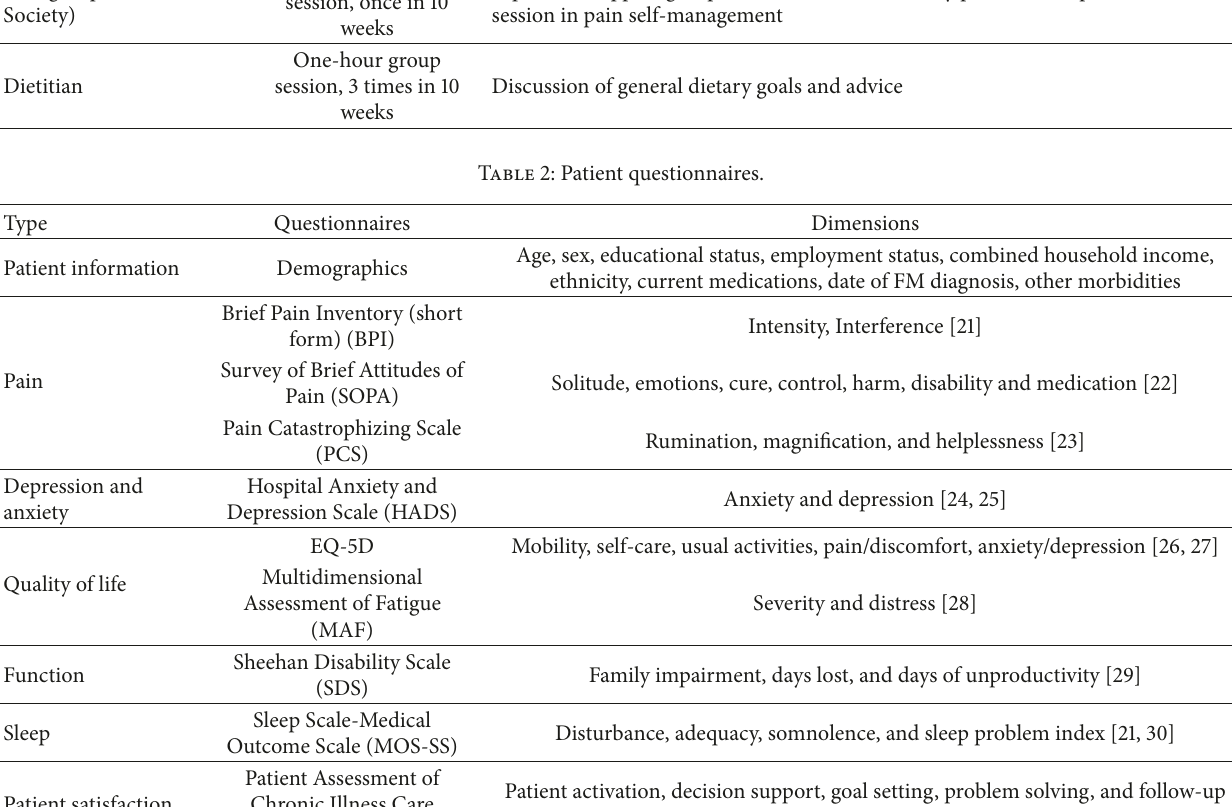
Table 2: Patient